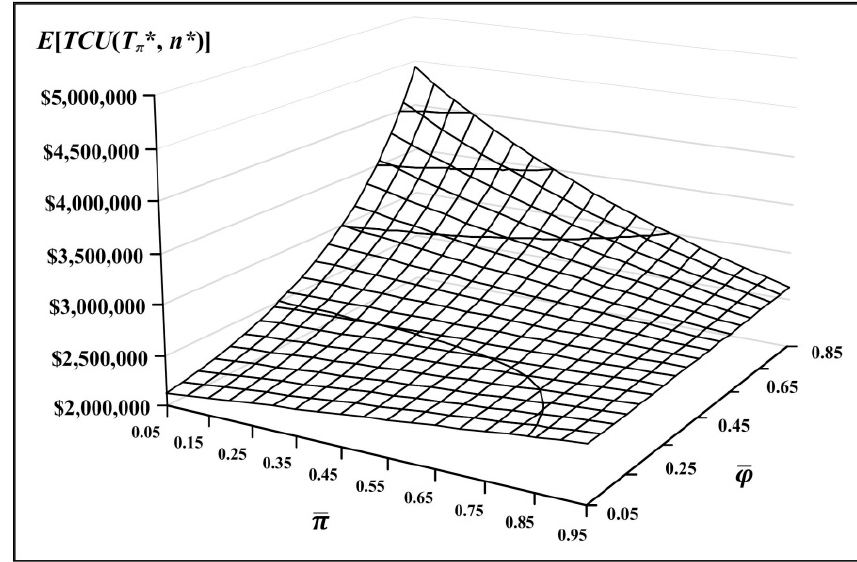
Figure 15. Joint impacts of changes in 𝜋(cid:3364) and 𝜑(cid:3364) on E [ TCU ( T π *, n *)].